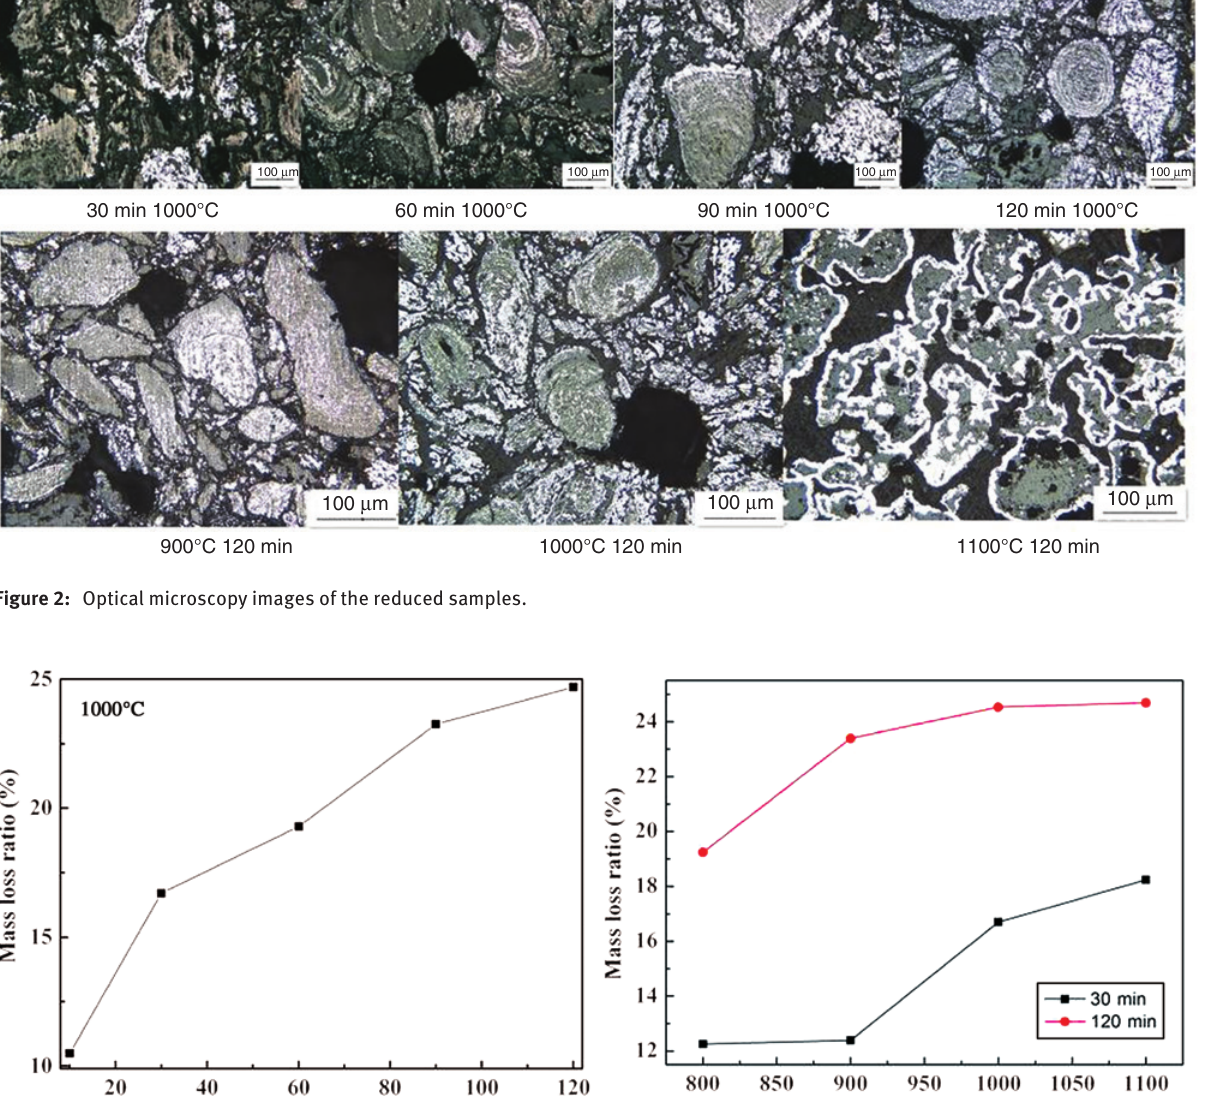
decreased from 30 to 90 min, and the speed of growth became smooth after 90 min. The mass loss ratio was more than 10% before 10 min, which was mainly produced by the samples volatile during the process of increasing tem- perature. With that and combined with Figure 4, the metal- lization ratio of the sample was nearly zero in the initial stage. When the reduction time was 30 min, the mass loss ratio of the sample was not changed below 900 ° C, but the mass loss ratio of the sample increased with the increase of temperature when the temperature was higher